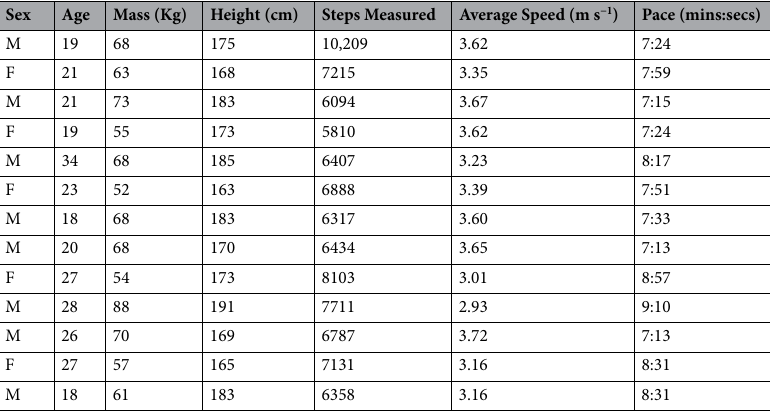
Table 1. Participant